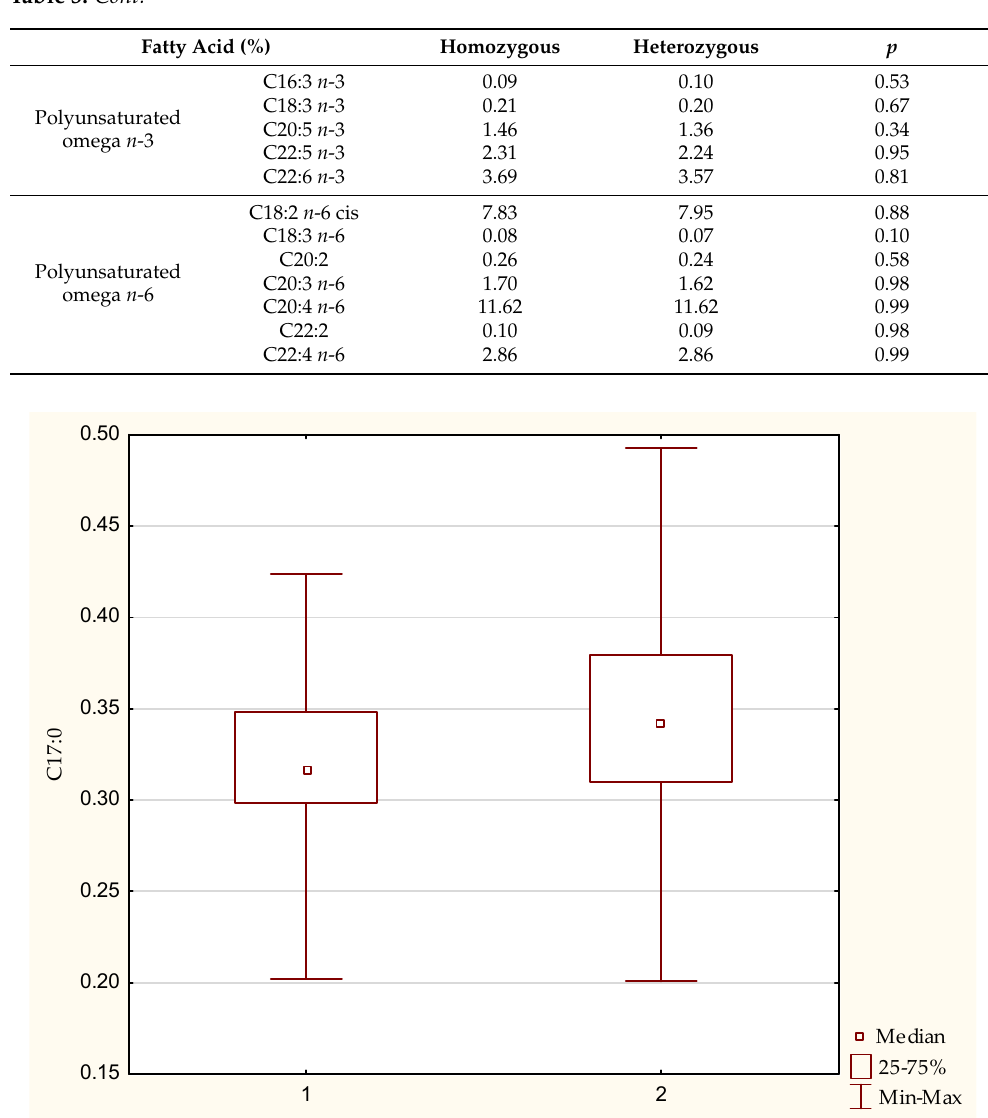
Figure 1. Percentage of heptadecanoic acid (C17:0) in the erythrocyte membrane in the hetero- (1) and homozygotic (2) groups, showing a statistical difference with significance p = 0.039. 3.2. Vitamins No statistically significant differences were found between the median serum concer- tations of vitamin A, vitamin E, vitamin K1 and cholecalciferol (25-hydroxyvitamin D3), as presented in Table 4. Table 4. Mean percentages of the serum levels of vitamin A, vitamin E, vitamin K1 and cholecalciferol (25-hydroxyvitamin D3) in the homozygous and heterozygous